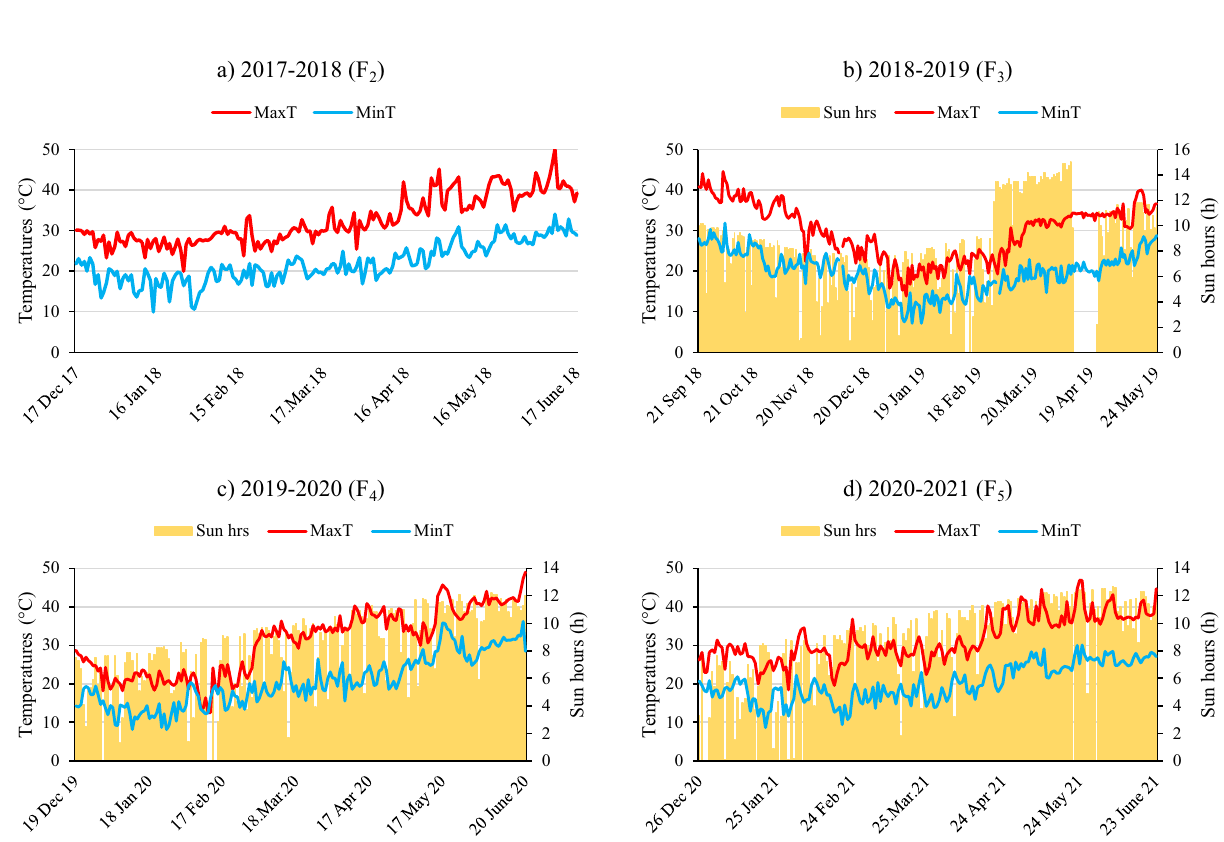
Figure 6. Daily minimum (MinT), maximum (MaxT) temperatures and daily sun hours in the glasshouse in 2017–18 ( a ), 2018–19 ( b ), 2019–20 ( c ) and 2020–21 ( d female parent and 7.5 times earlier than the mean of the male parent in terms of the number of days to flower- ing and pod setting (Table 3 and Fig. 3). The earliest progeny in the F 3 population were 3.9 times earlier than the mean of the female parent and 9.5 times earlier than the mean of the male parent in terms of the number of days to flowering and pod setting (Table 3 and Fig. 3). F 2 and F 3 populations have shown bimodal distribution for flowering time as a segregation ratio of late to early flowering of 9:7 (Fig. 3a,b). Under short-day conditions, this distribution demonstrated that flowering time is controlled by two genes with duplicate recessive epistasis or complementary gene action. Similar findings on 9:7 distribution for flowering time were reported by in F 2 population derived from the intraspecific crosses in pea 27 and chickpea 72 . A bimodal distribution, late and early, was discovered for the flowering node using F 2 population in pea, and the gene responsible for the late flowering was named Sn 73 . Snsn gene pair was responsible for the difference between early and late flowering in intraspecific pea crosses 74 . Approximately 20 loci were pointed out to be involved in pea flowering variation 29 ,